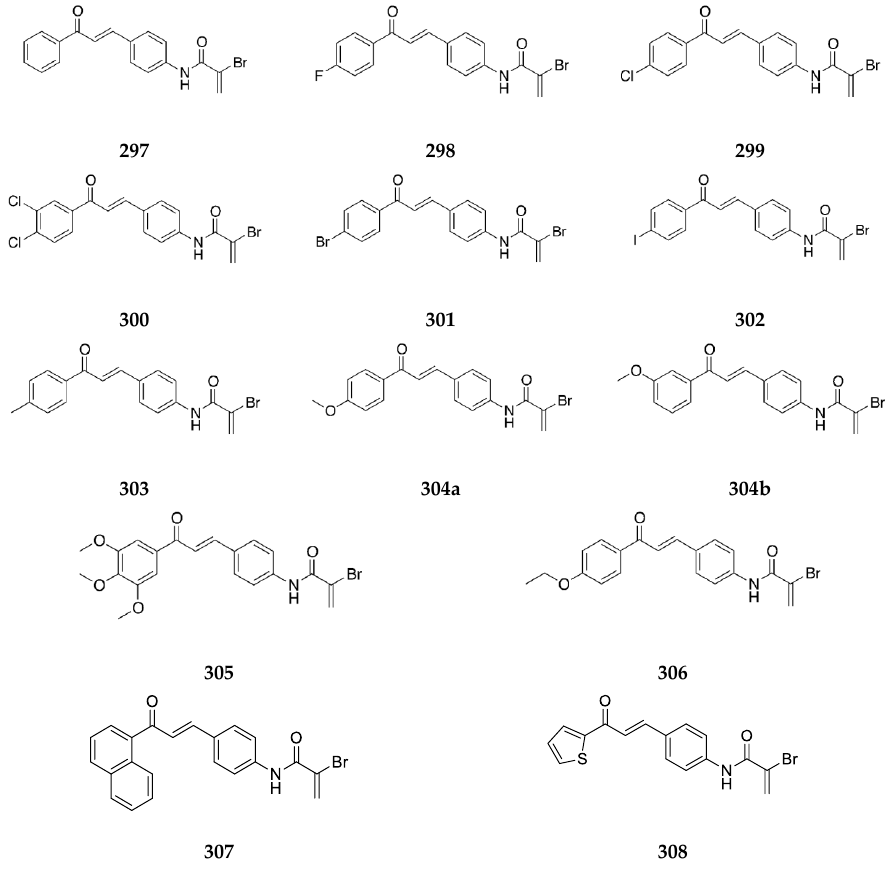
Figure 77. Chemical structure of α-bromoacryloylamido-chalcone derivatives.